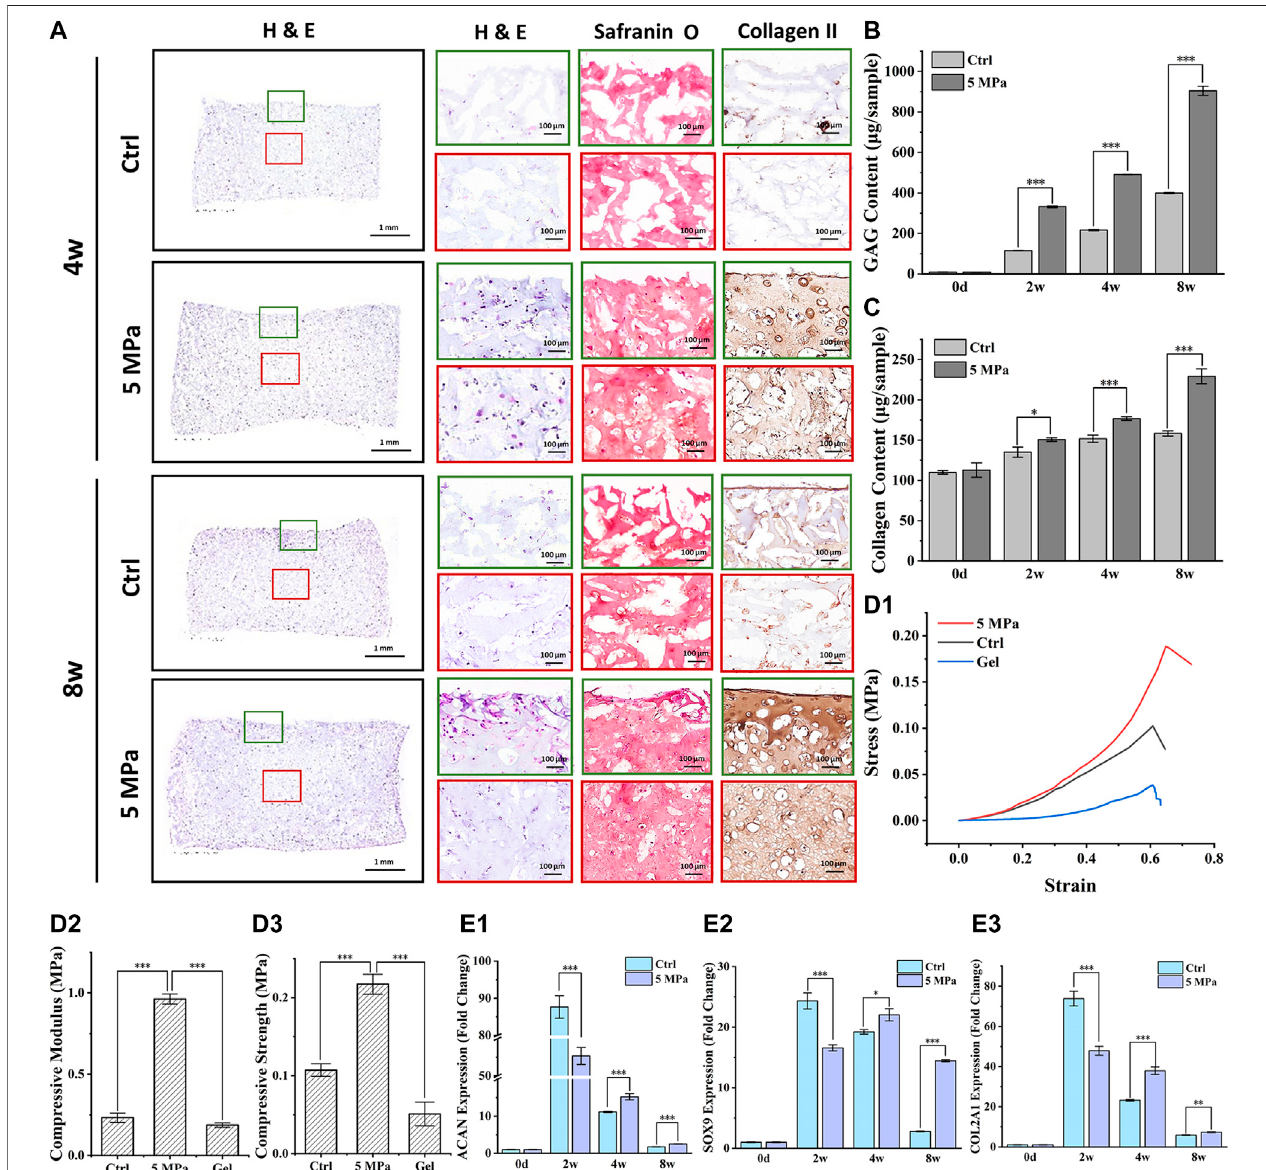
FIGURE 5 | Evaluation of in vitro cartilage regeneration mediated by HP. (A) H & E, Safranin O, and type II collagen staining of CHPC cultured in vitro . (B) GAG content in the HP group and control group showed a signi fi cant difference after 1 week (p < 0.001) of in vitro culture. (C) The difference in collagen content between the two groups began to emerge after 4 weeks (p < 0.001). (D) Stress-strain curve (D1) , the compressive modulus (D2) , and compressive strength (D3) in the HP group weremuch higher thaninthe controlgroup andHPC hydrogels (p < 0.001)during invitro culture. (E) Thefoldchangeof ACAN (E1) , COL2A1 (E2) ,and SOX9 (E3) expression in the HP group were higher than those in the control group after 4 weeks of in vitro culture (p < 0.05). Green frames indicate the peripheral regions and red frames indicate the central regions.